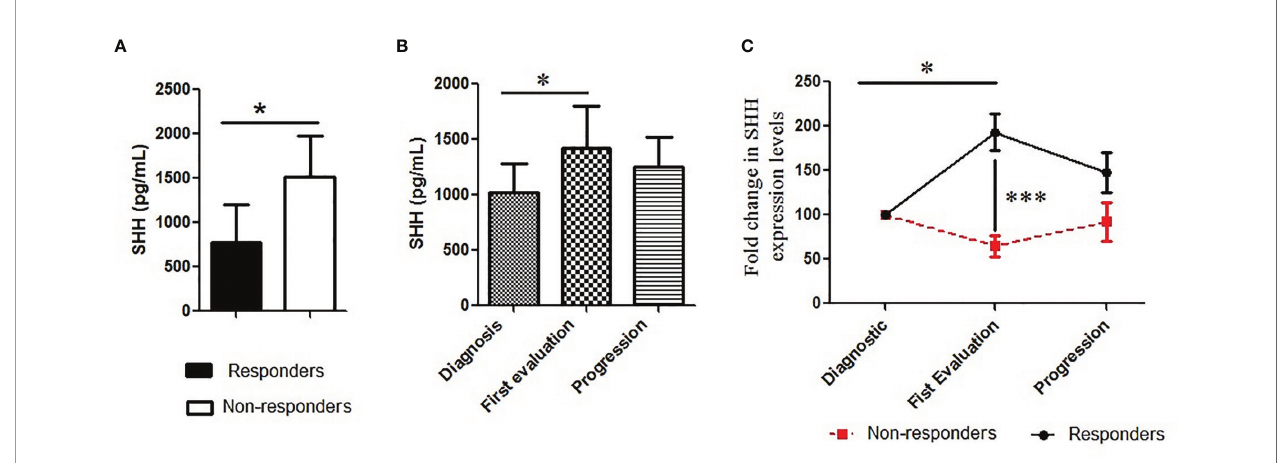
FIGURE 3 | Pattern of plasmatic Shh concentration along the course of the disease: (A) Shh was analyzed in plasma collected from patients and classi fi ed according to (A) treatment response (responders vs. non-responders); (B, C) and treatment steps (diagnosis or base line, the fi rst evaluation and the progression). A Mann – Whitney test was used to analyze the differences between means. * p < 0.05, *** p <